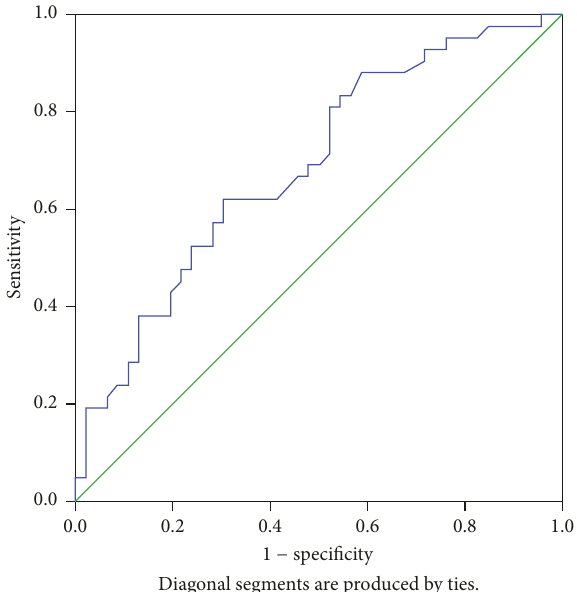
Figure 1: ROC curve 1. Receiver Operating Characteristic (ROC) Curve illustrates sensitivity and specificity of mean PDW values for detection of mild, moderate, and severe